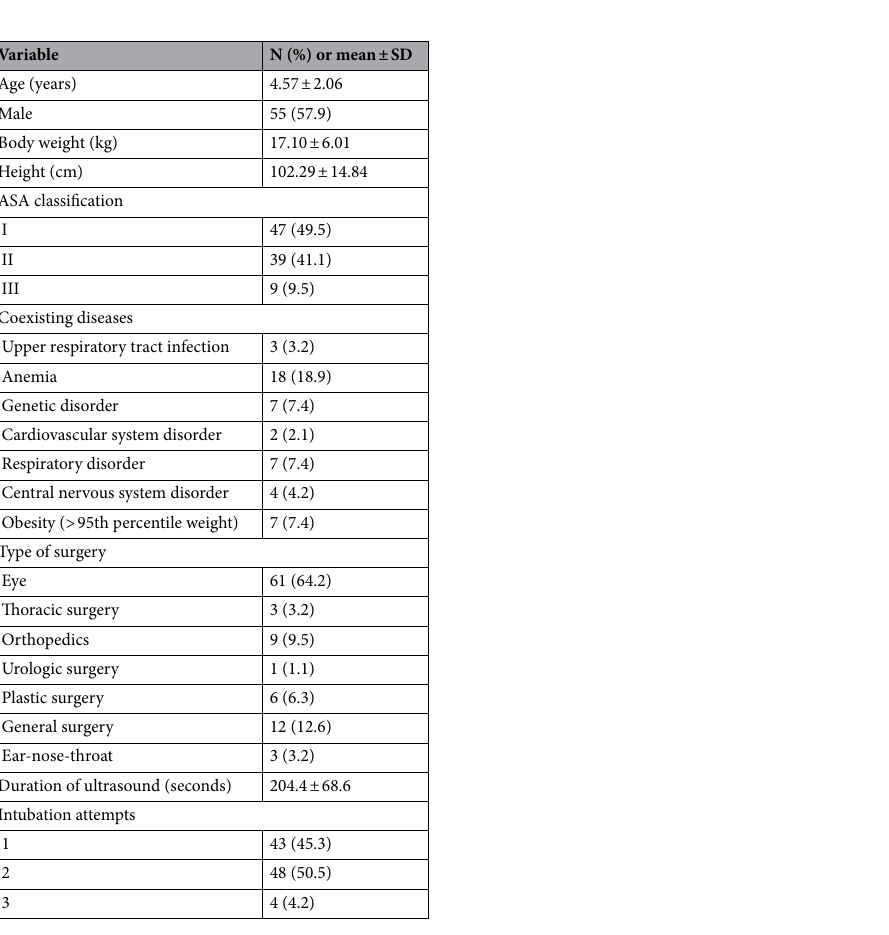
Figure 2. Flow diagram of the study. ASA American Society of Anesthesiologists.